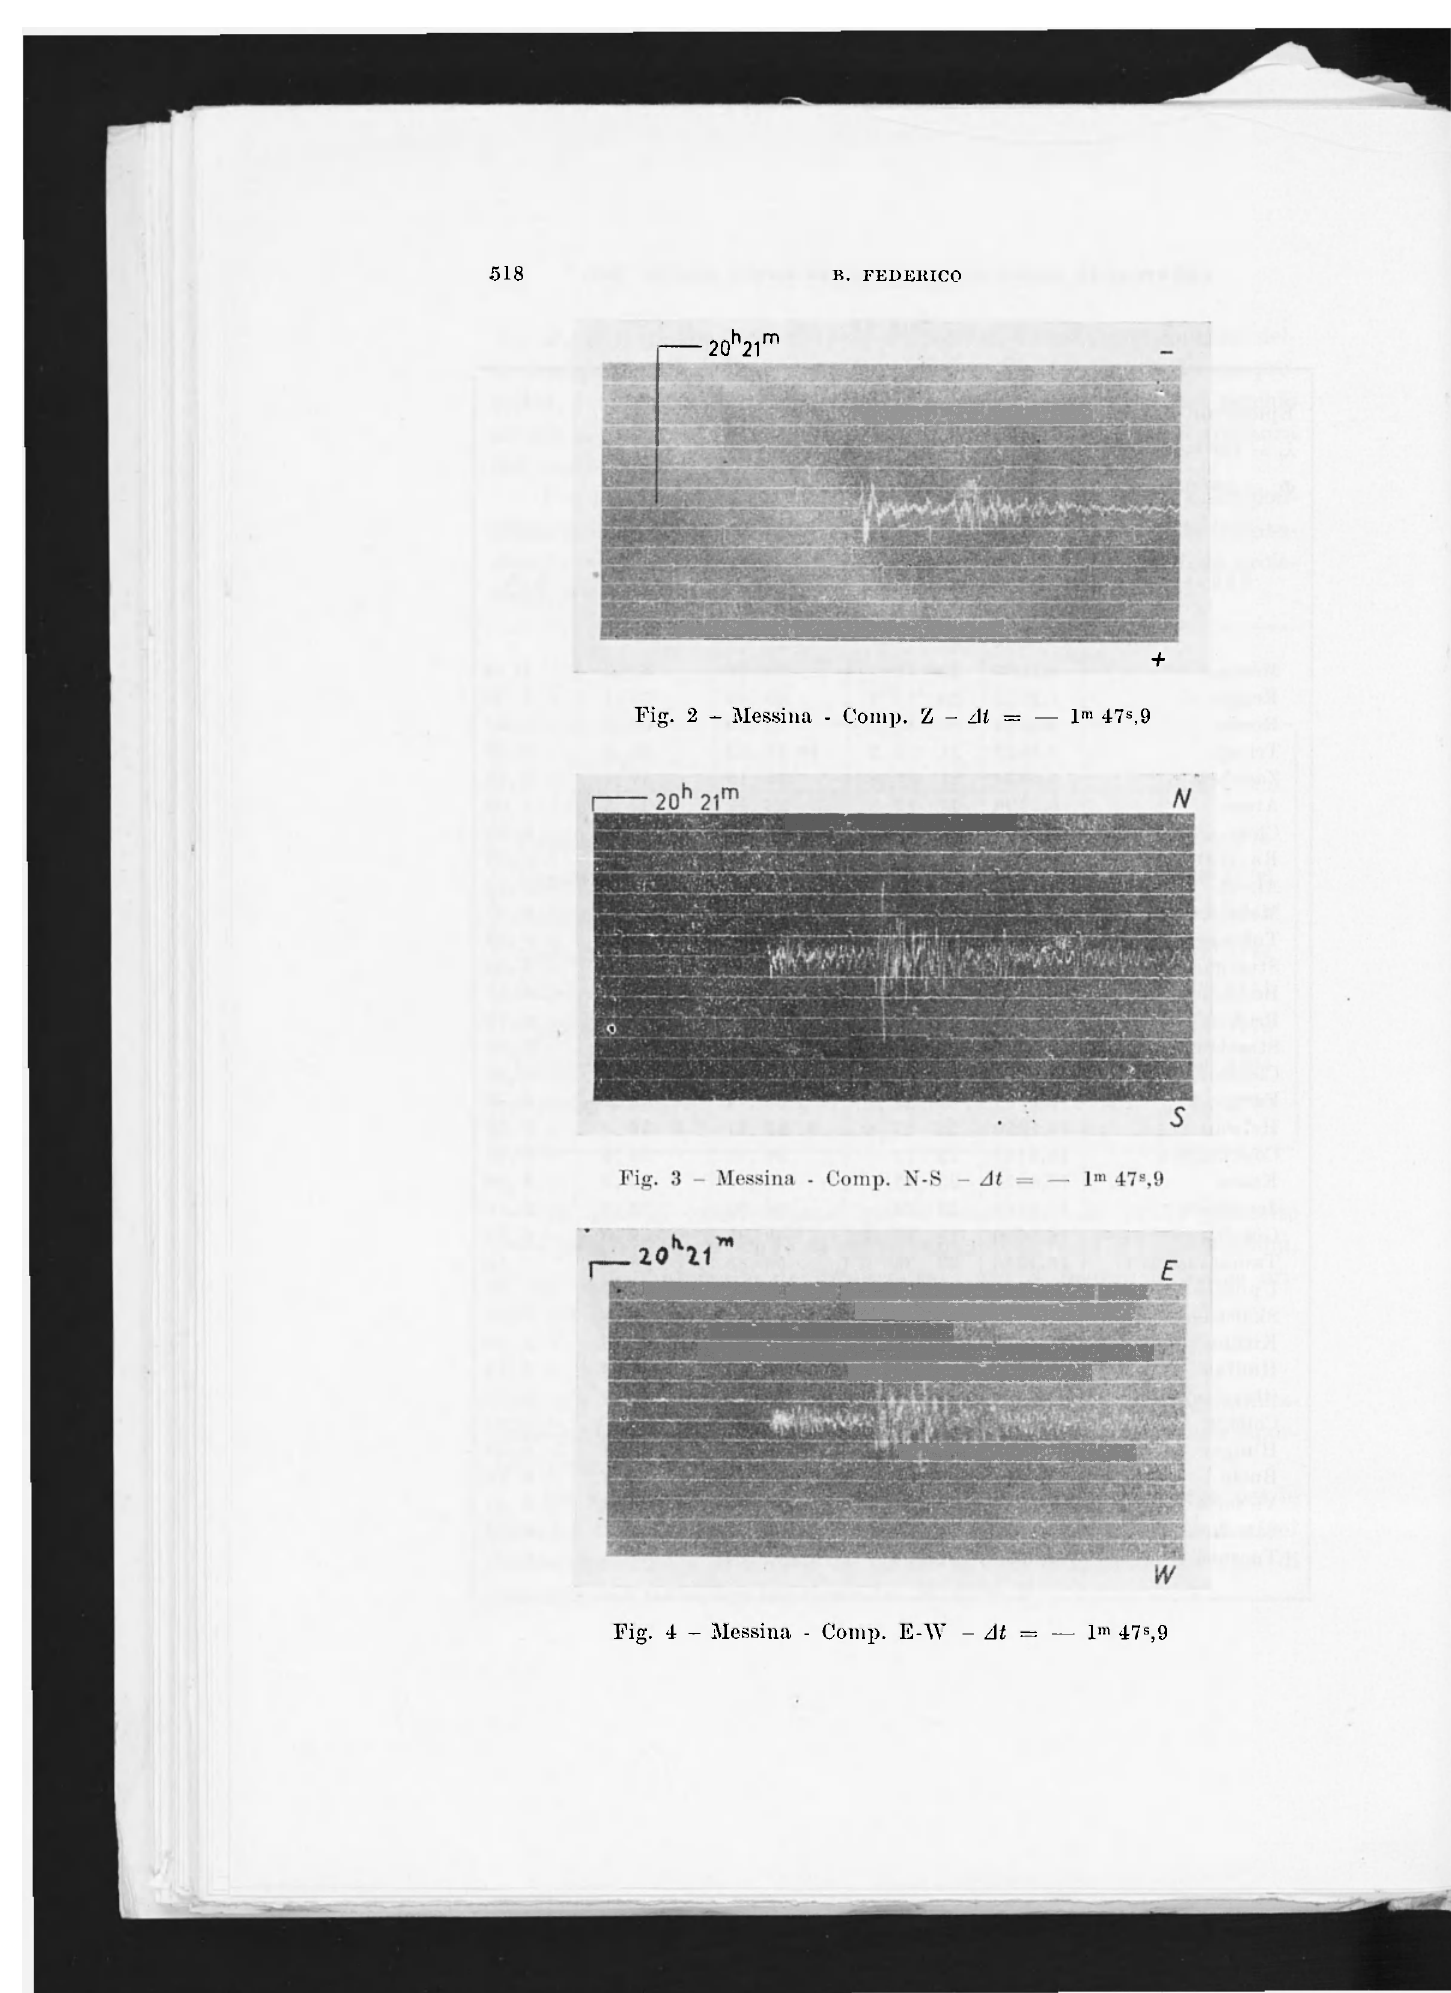
Fig. 2 - Messina - Comp. Z - At = — l m 47 s ,9